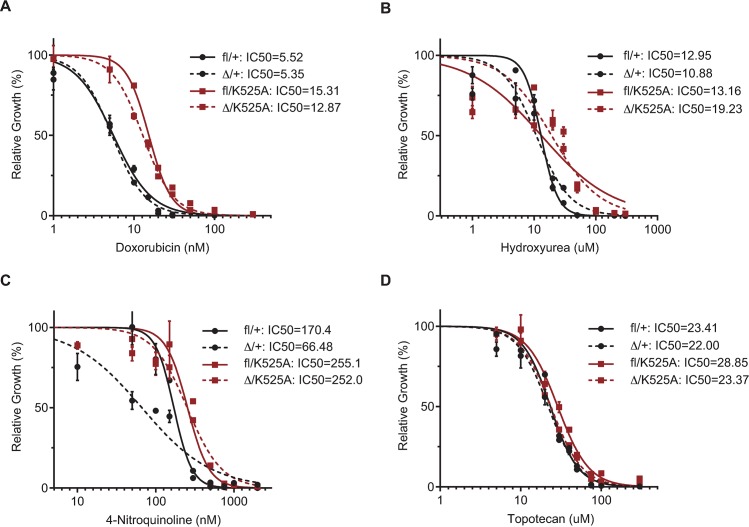
In vitro sensitivity to DNA damaging agents is not modified by helicase-dead mutation.Dose-response curves for relative growth rate of HoxB8 immortalized R26-CreER Recql4fl/K525A (red) and R26-CreER Recql4fl/+ (black). Dotted lines represent cells expressing the K525 mutant only after the floxed allele was excised by tamoxifen addition. Cells were incubated for 48 hours with the following drugs: (A) Doxorubicin. (B) Hydroxyurea. (C) 4-Nitroquinoline. (D) Topotecan. The calculated IC50 values are stated for each genotype/treatment.